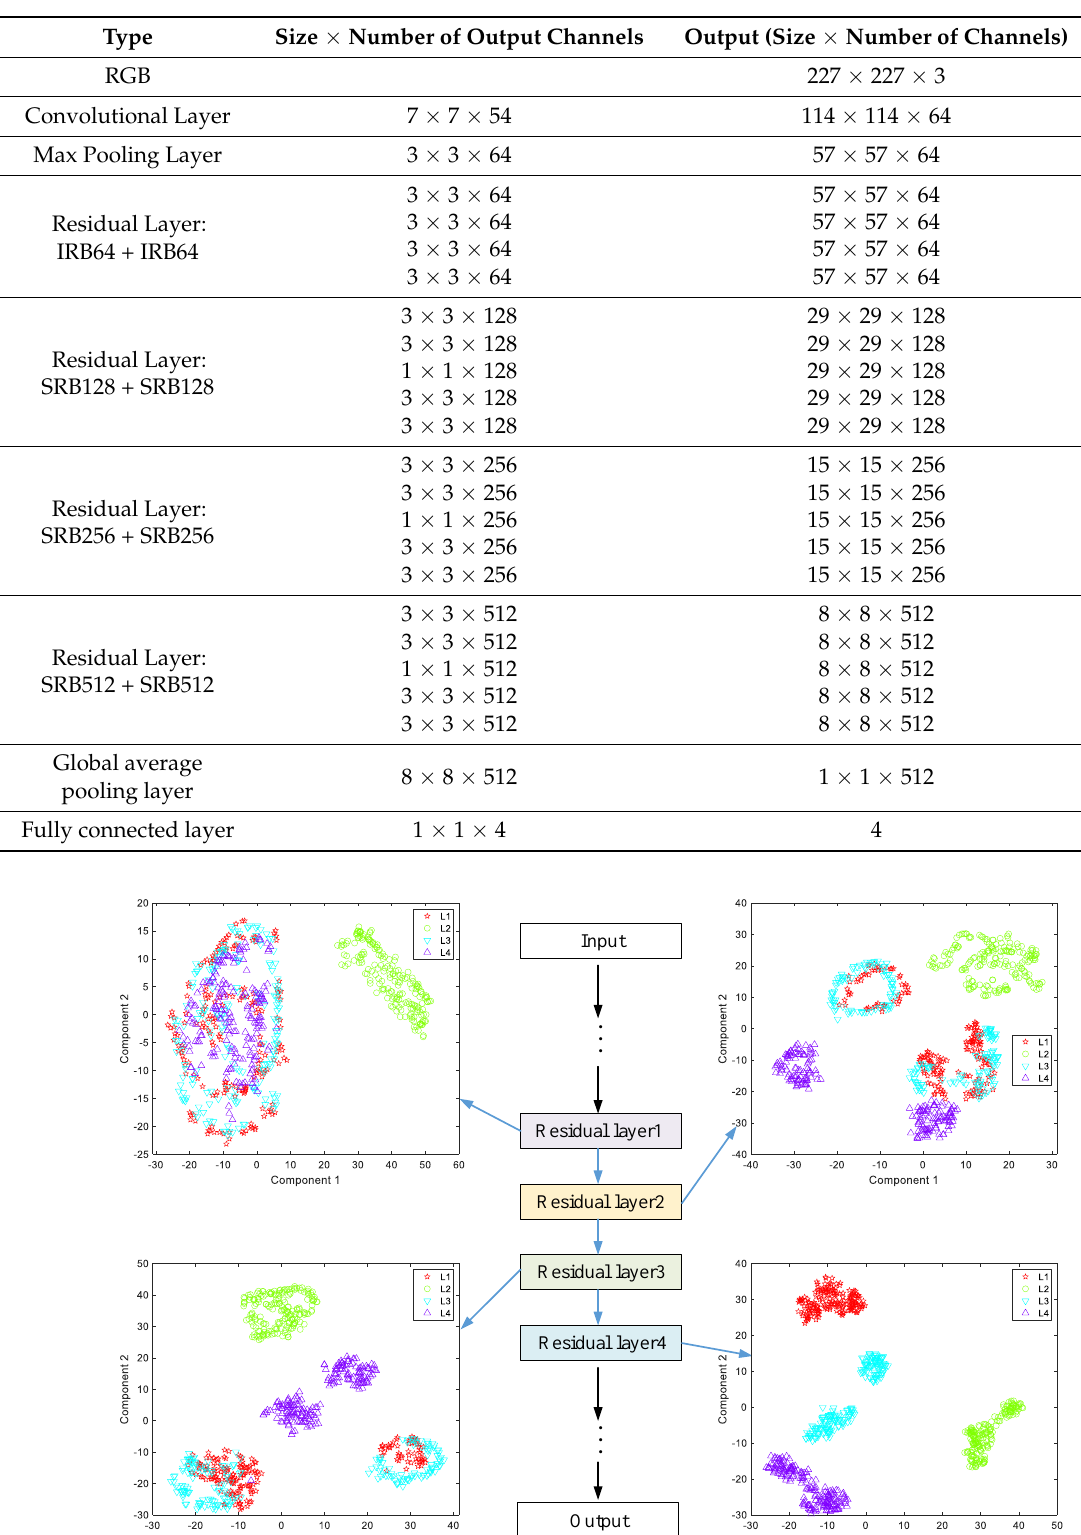
Table 6. Setting the model parameters of the ResNet18 network.